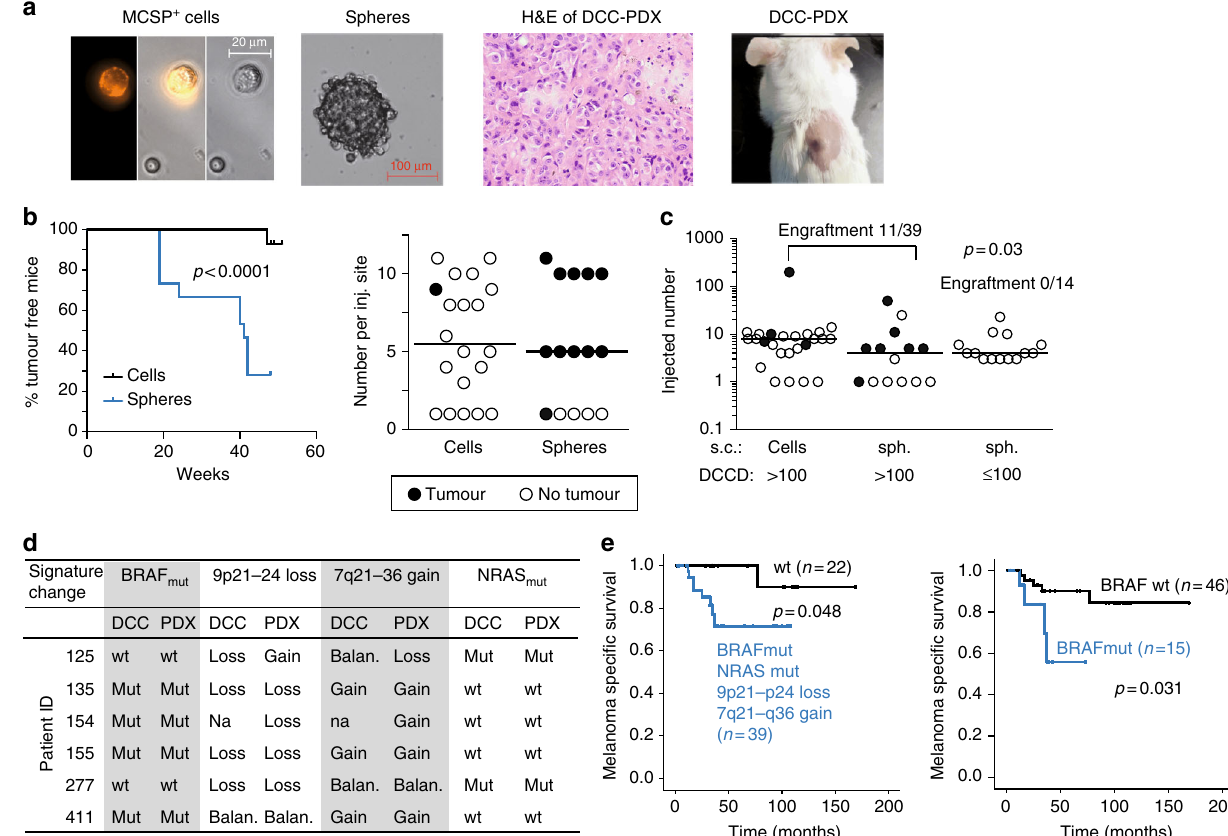
Fig. 8 Tumour-forming ability of DCCs before and after colonisation and patient survival. a Left to right: Isolated MCSP + DCCs from a patient-SLN; DCC- derived sphere; H&E staining of a patient DCC-derived xenograft (DCC-PDX); DCC-PDX (7 s.c. injected DCCs). Pictures are representative for 15 transplanted patient samples. b Side-by-side transplantation of paired MCSP + DCCs ( n = 3 patients, 20 injection sites) and DCC-derived spheres ( n = 3 patients, 15 injection sites) from the same patient into NSG mice. Left: Kaplan – Meier analysis of tumour-free mice ( p < 0.0001, log-rank test). Right: number of injected MCSP + DCCs and DCC-derived spheres per injection site. Black fi lled circles indicate tumour formation. c Number of MCSP + DCCs (DCCD > 100: n = 25 injection sites) or DCC-derived spheres (DCCD > 100: n = 14 injection sites; DCCD ≤ 100: n = 14 injection sites) that were transplanted into NSG mice. Each circle represents one injection site. Black fi lled circles indicate tumour formation (engraftment). The p value ( p = 0.03 Fisher ’ s exact test) indicates a signi fi cant difference in the engraftment rate for samples with DCCD > 100 (cells and spheres were pooled, n = 39, n = 10 patients) vs. DCCD ≤ 100 (spheres, n = 14, n = 5 patients). d Mutational status of patient-derived DCCs and their respective xenografts regarding the colonisation signature from Fig. 7a and Supplementary Table 3 (i.e., loss of genetic locus 9p21 – 24 and gain of 7q21 – 36, BRAF mut and NRAS mut), n = 6 patients. Note that samples 125 and 277 add NRAS mutations to the colonisation signature. e Left: Kaplan – Meier survival analysis of patients with DCCs that display at least one of the fi nal colonisation signature features (i.e., loss of genetic locus 9p21 – 24, gain of 7q21 – 36, BRAF mut or NRAS mut, n = 39)